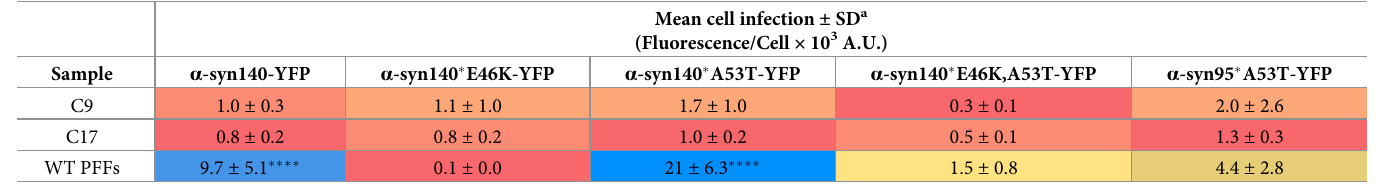
Table 3. Infectivity of TgM47 +/- passaged WT PFFs in cultured cells.